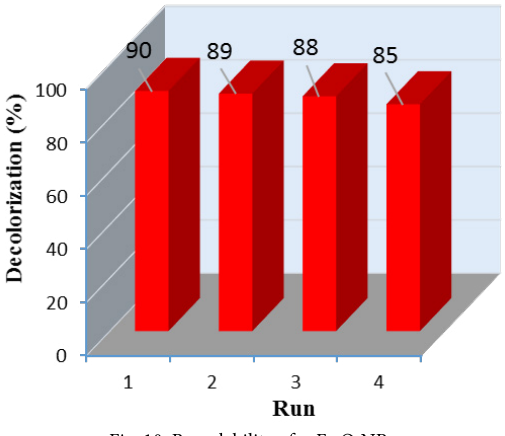
Figure. 10. Recyclability of α -Fe 2 O 3 NP. Fig. 10. Recyclability of α-Fe 2 O 3